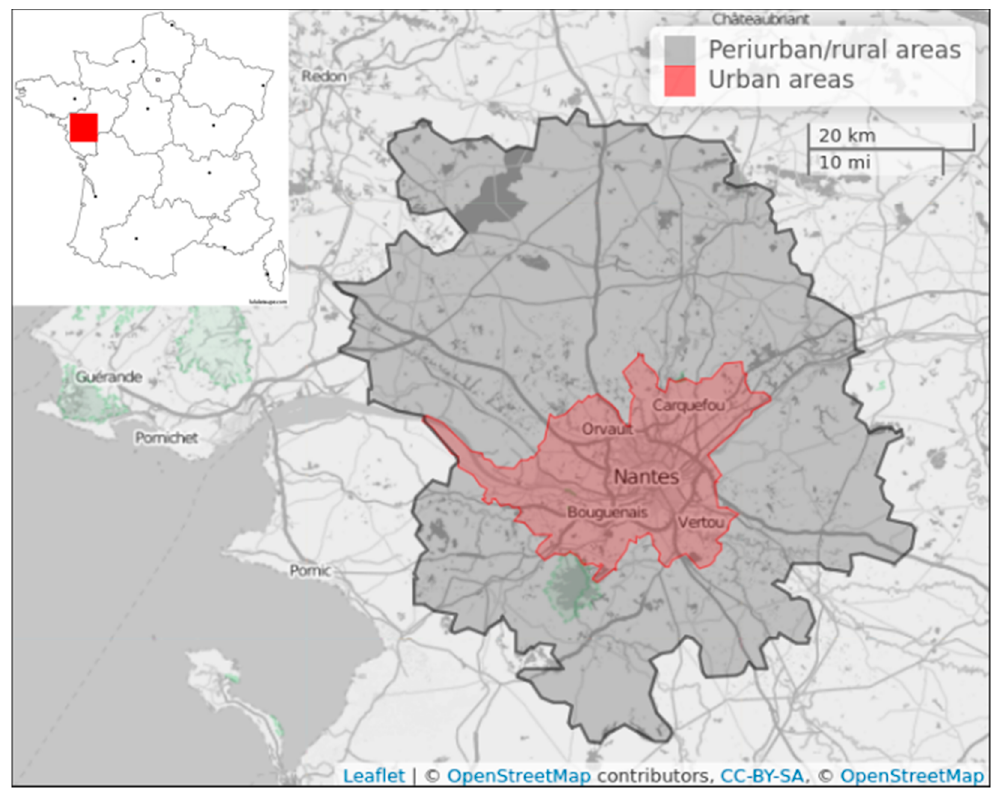
Figure 1. Location map.